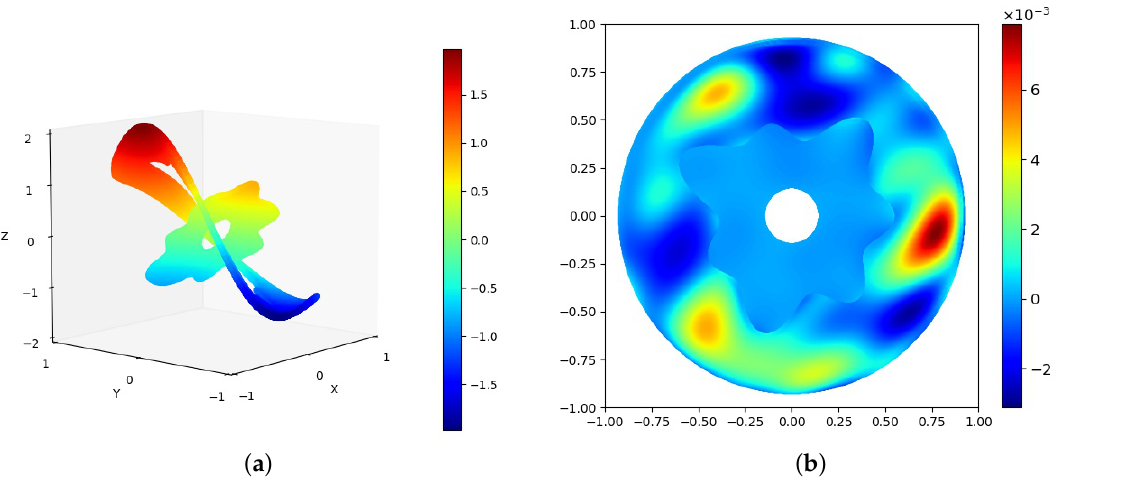
Figure 8. ( a ) Problem geometry and ( b ) training points.